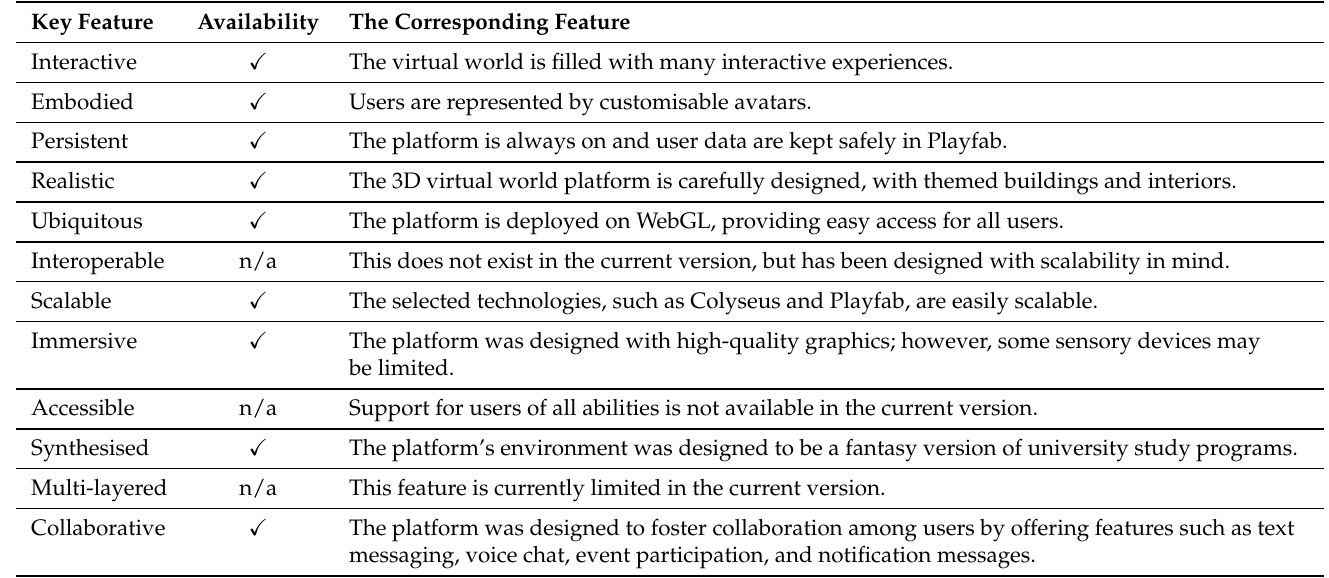
Table 2. A table of metaverse key features and the corresponding features in the proposed